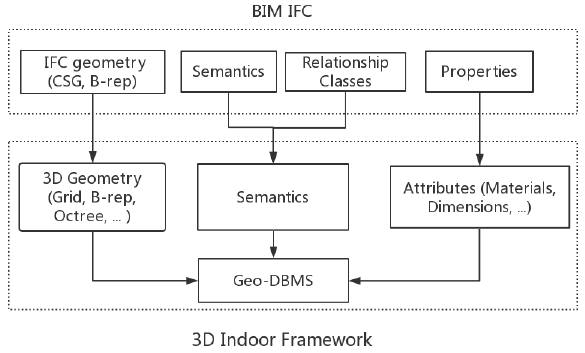
Figure 2. Conceptual mapping of IFC and the 3D indoor